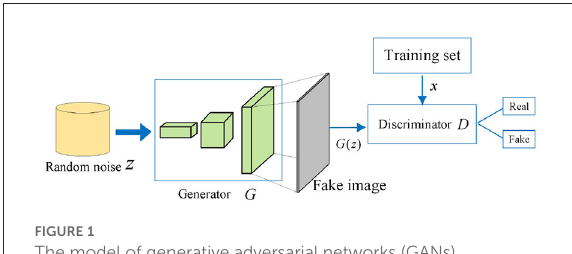
FIGURE1 The model of generative adversarial networks